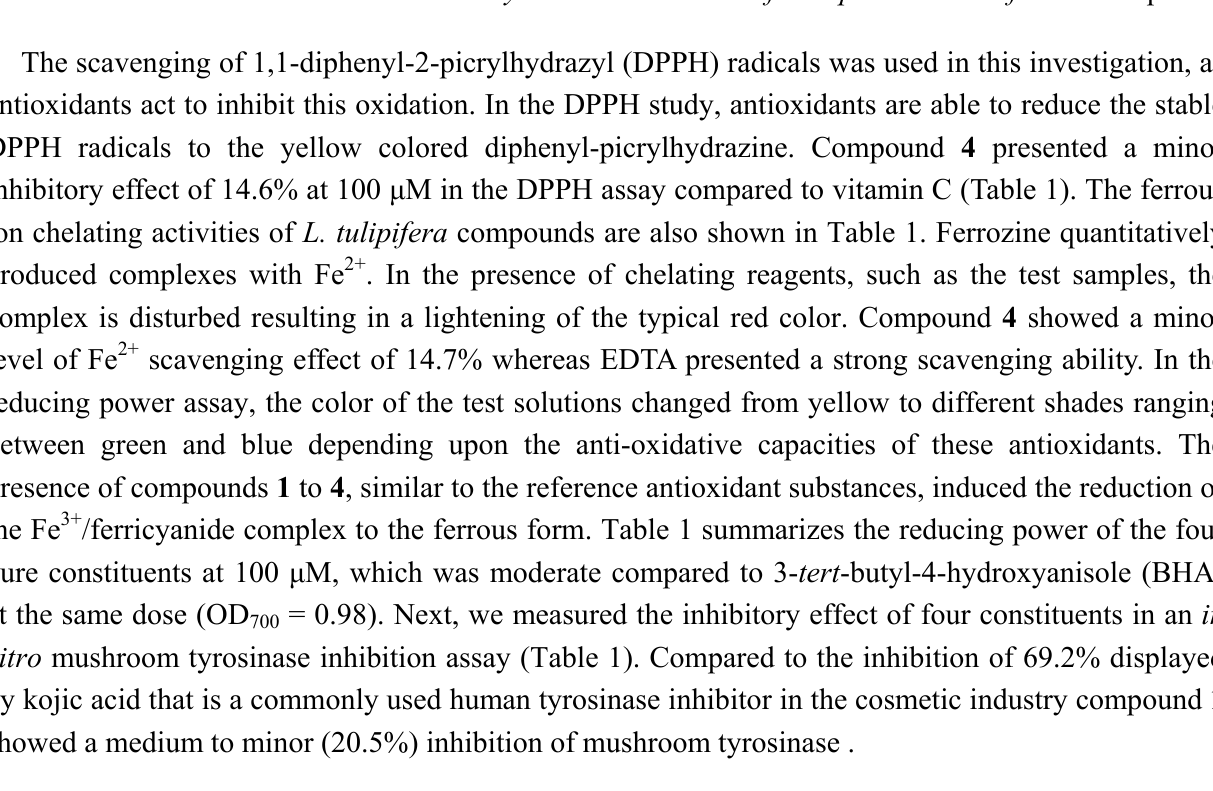
Table 1. Antioxidant activity and the inhibition of L. tulipifera to mushroom tyrosinase